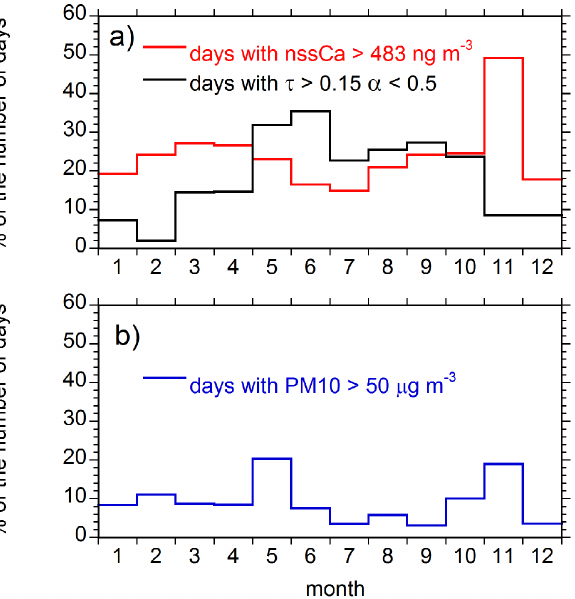
Fig. 6. a) Percentage of Saharan dust events observed in each month identified from the aerosol optical properties (black line) and from the nssCa amount (red line) and (b) percent number of days with PM 10 >50µgm − 3